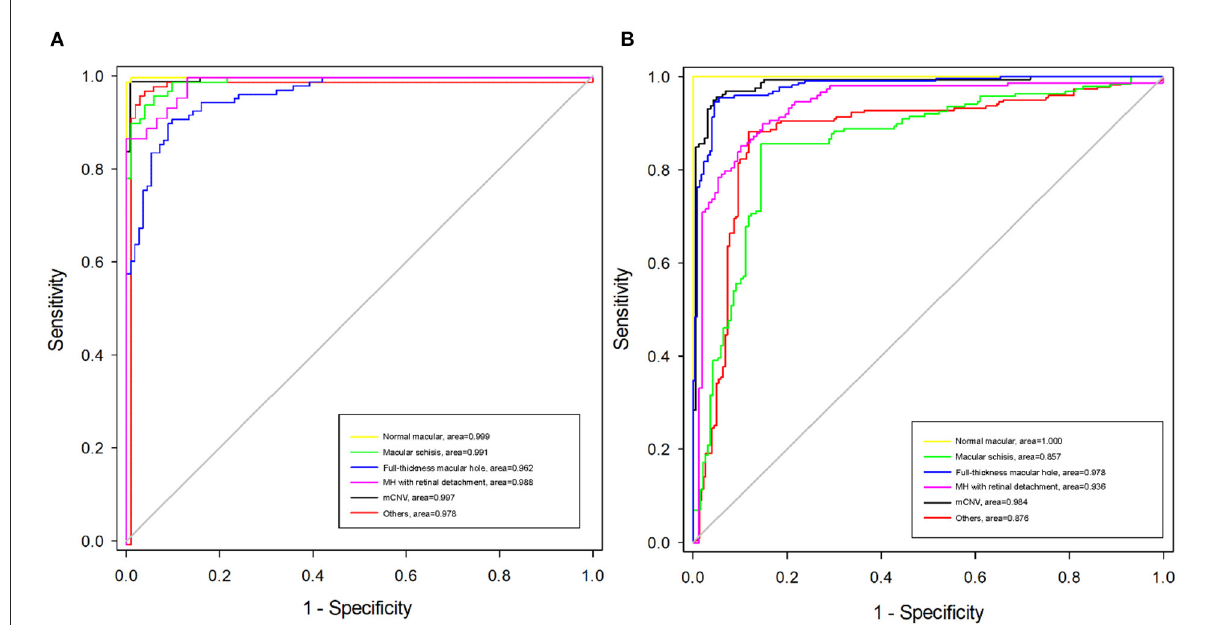
FIGURE6 The confusion matrixes of algorithm B in both test and external validation datasets. (A) The confusion matrix of algorithm B in the test dataset. (B) The confusion matrix of algorithm B in the external validation dataset.